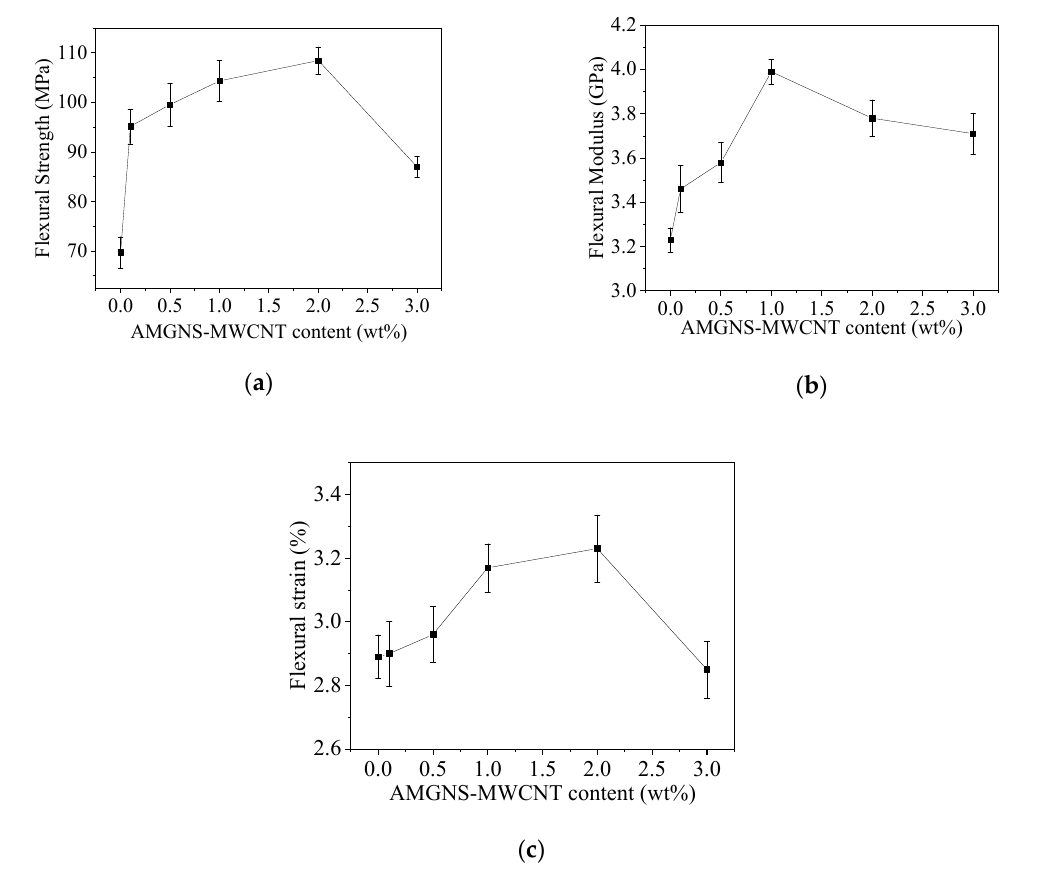
Figure 4. Flexural properties of the AMGNS-MWCNT / epoxy nanocomposites: ( a ) flexural strength; ( b ) flexural modulus; ( c ) flexural strain.